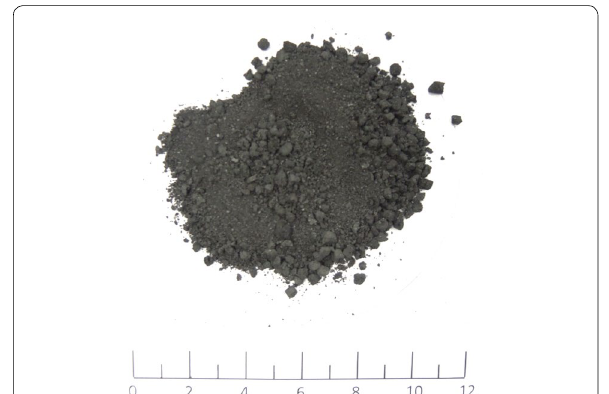
Fig. 5 The produced char from spent coffee grounds, scale in cm